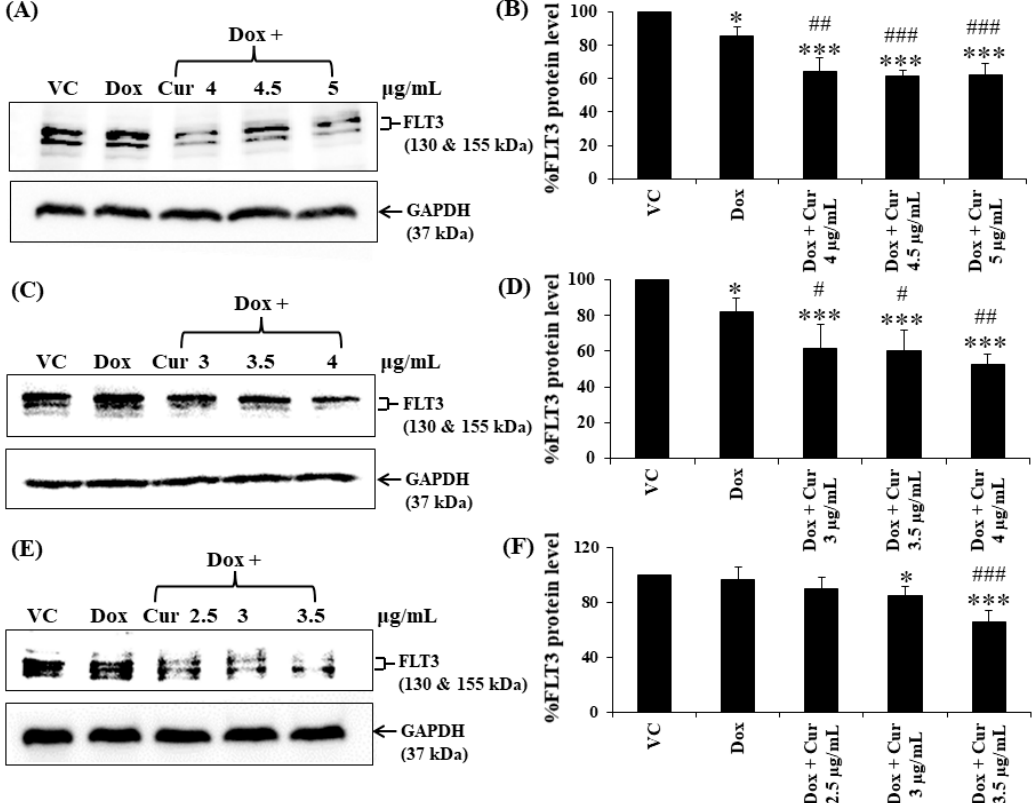
Figure 6. FLT3 protein expression of KG-1a, KG-1, and EoL-1 cells following treatment with Dox and combination of fixed concentration of Dox and various non-toxic concentrations of Cur for 48 h. Protein bands ( A ) and percentage ( B ) of KG-1a cells treated with DMSO (VC), Dox (15 ng/mL), Dox + Cur (4 μ g/mL), Dox + Cur (4.5 μ g/mL), and Dox + Cur (5 μ g/mL), for 48 h. Protein band ( C ) and percentage ( D ) of KG-1 cells treated with DMSO (VC), Dox (22 ng/mL), Dox + Cur (3 μ g/mL), Dox + Cur (3.5 μ g/mL), and Dox + Cur (4 μ g/mL) for 48 h. Protein band ( E ) and percentage ( F ) of EoL-1 cells were treated with DMSO (VC), Dox (2.8 ng/mL), Dox + Cur (2.5 μ g/mL), Dox + Cur (3 μ g/mL), and Dox + Cur (3.5 μ g/mL) for 48 h. Whole protein lysates (80 μ g/lane) were loaded onto SDS-PAGE. The data are shown as mean ± SD from 3 independent experiments. The significance of mean differences was assessed using one-way ANOVA. * p < 0.05 and *** p < 0.001 compared with VC. # p < 0.05, ## p < 0.01, and ### p < 0.001 compared with single-Dox treatment.